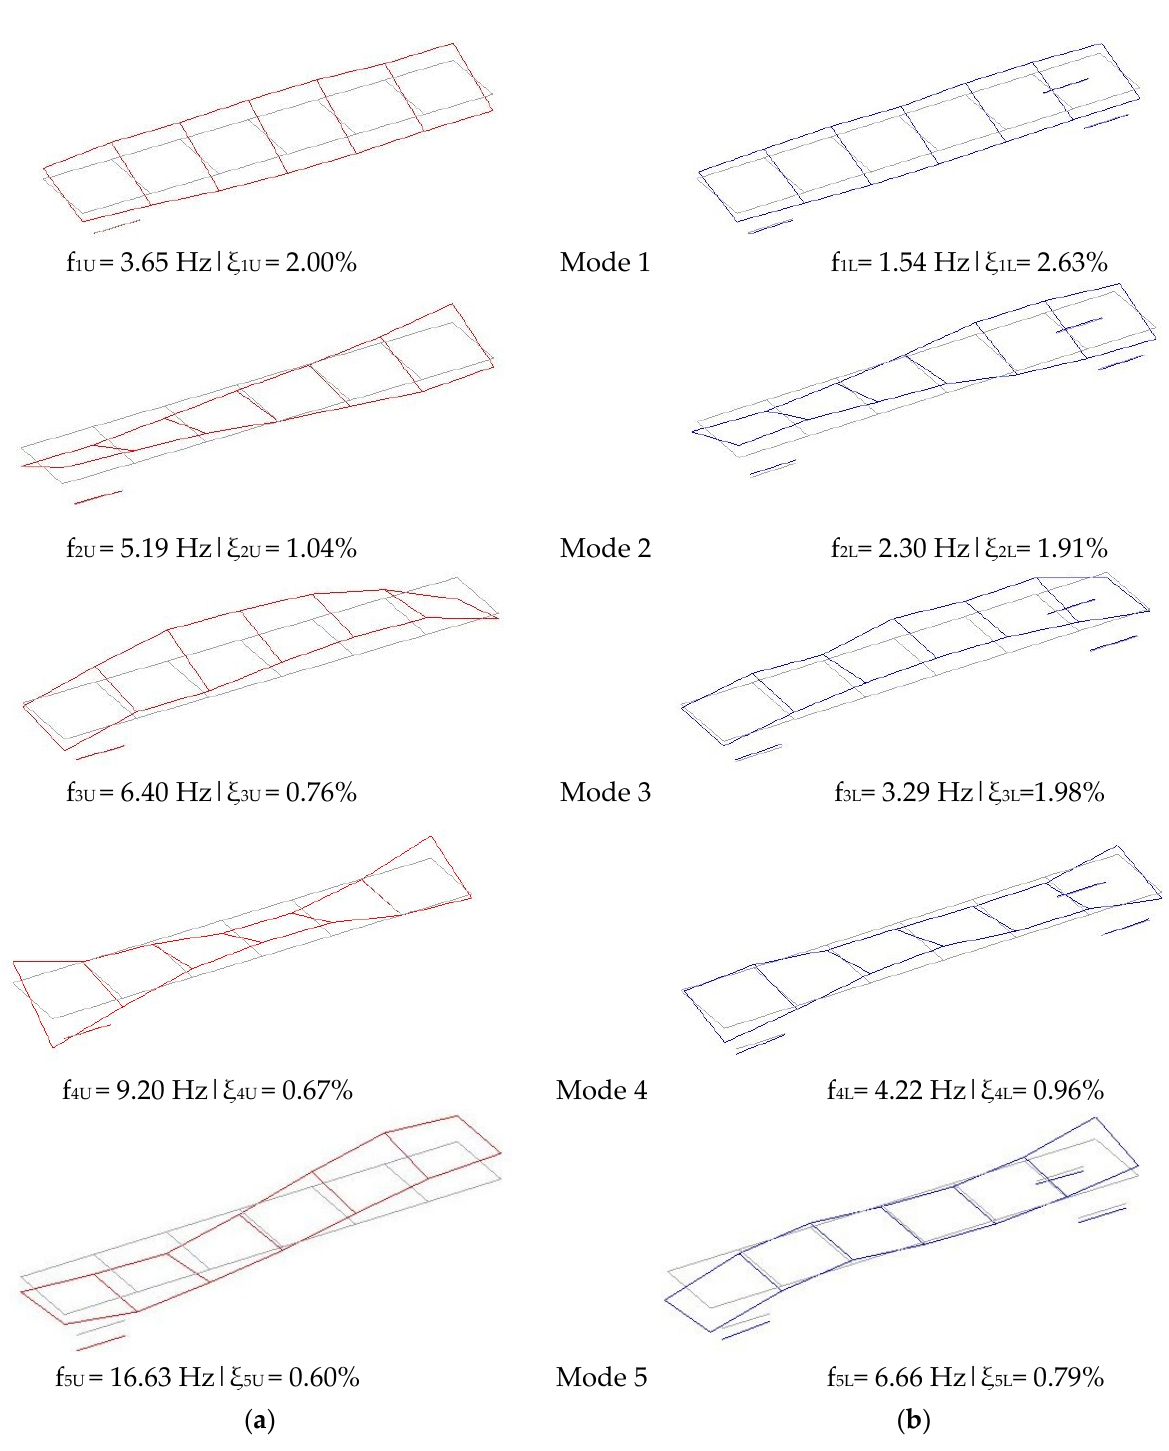
Figure 9. Experimental modal parameters: ( a ) unloaded configuration, ( b ) loaded